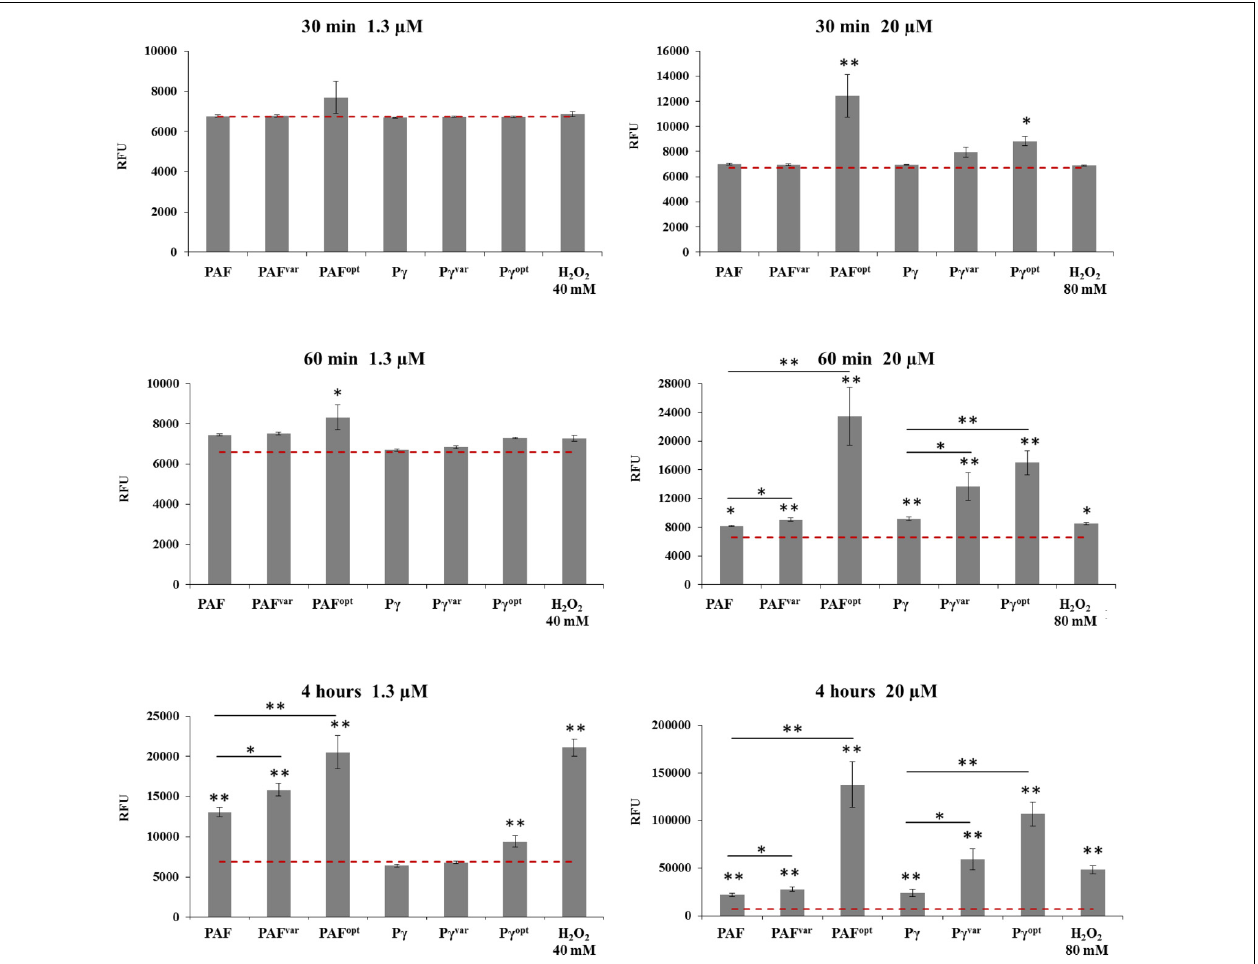
FIGURE 6 | ROS production in C. albicans after 0.5, 1, and 4 h of AMP treatment. Cells were exposed to 1.3 and 20 µ M AMP. The dotted red line indicates the background RFU signal of untreated cells (negative control). H 2 O 2 was used at 40 and 80 mM as positive control. Values represent mean ± SD; ∗ P ≤ 0.05 and ∗∗ P ≤